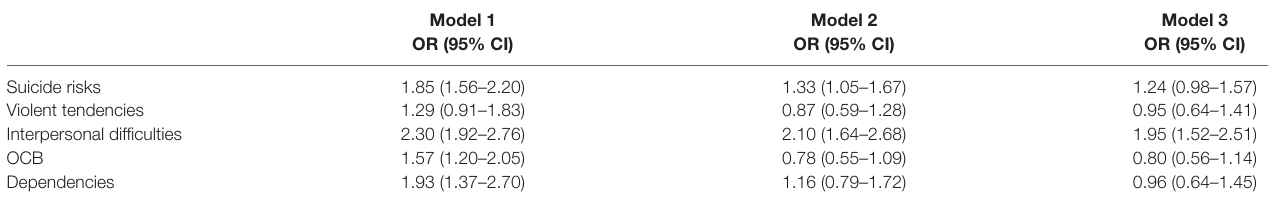
TABLE 3 | Association between the hikikomori condition and psychiatric